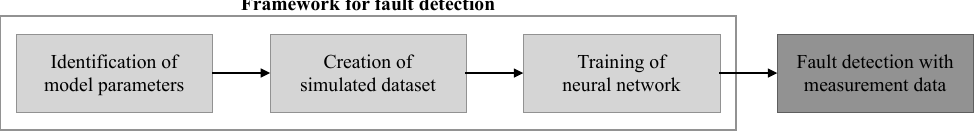
Figure 5. Sequence of the individual steps of the fault detection framework up to the application with real measurement data.